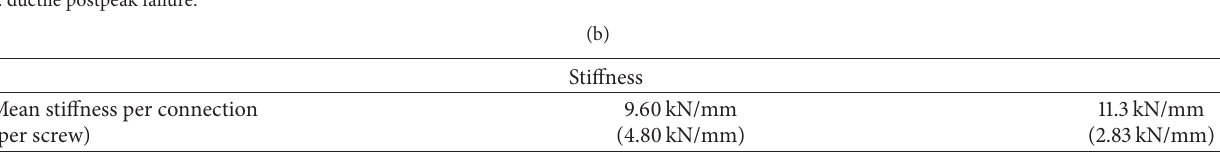
Table 2: Result of the shear tests.